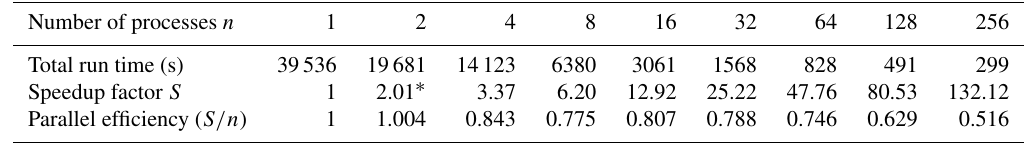
Table 4. Run time and speedup for the multi-node experiment with 500 million particles. Up to 16 nodes in the Abel cluster (University of Oslo).